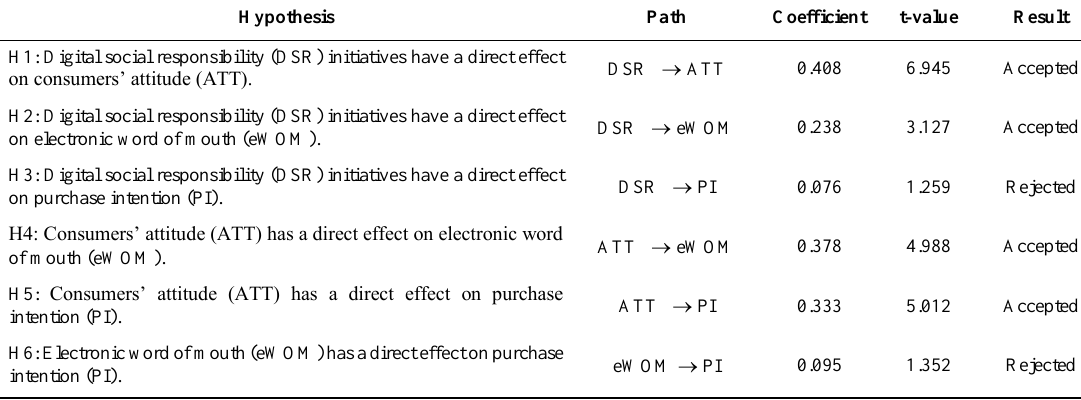
Table 4. Hypotheses test results